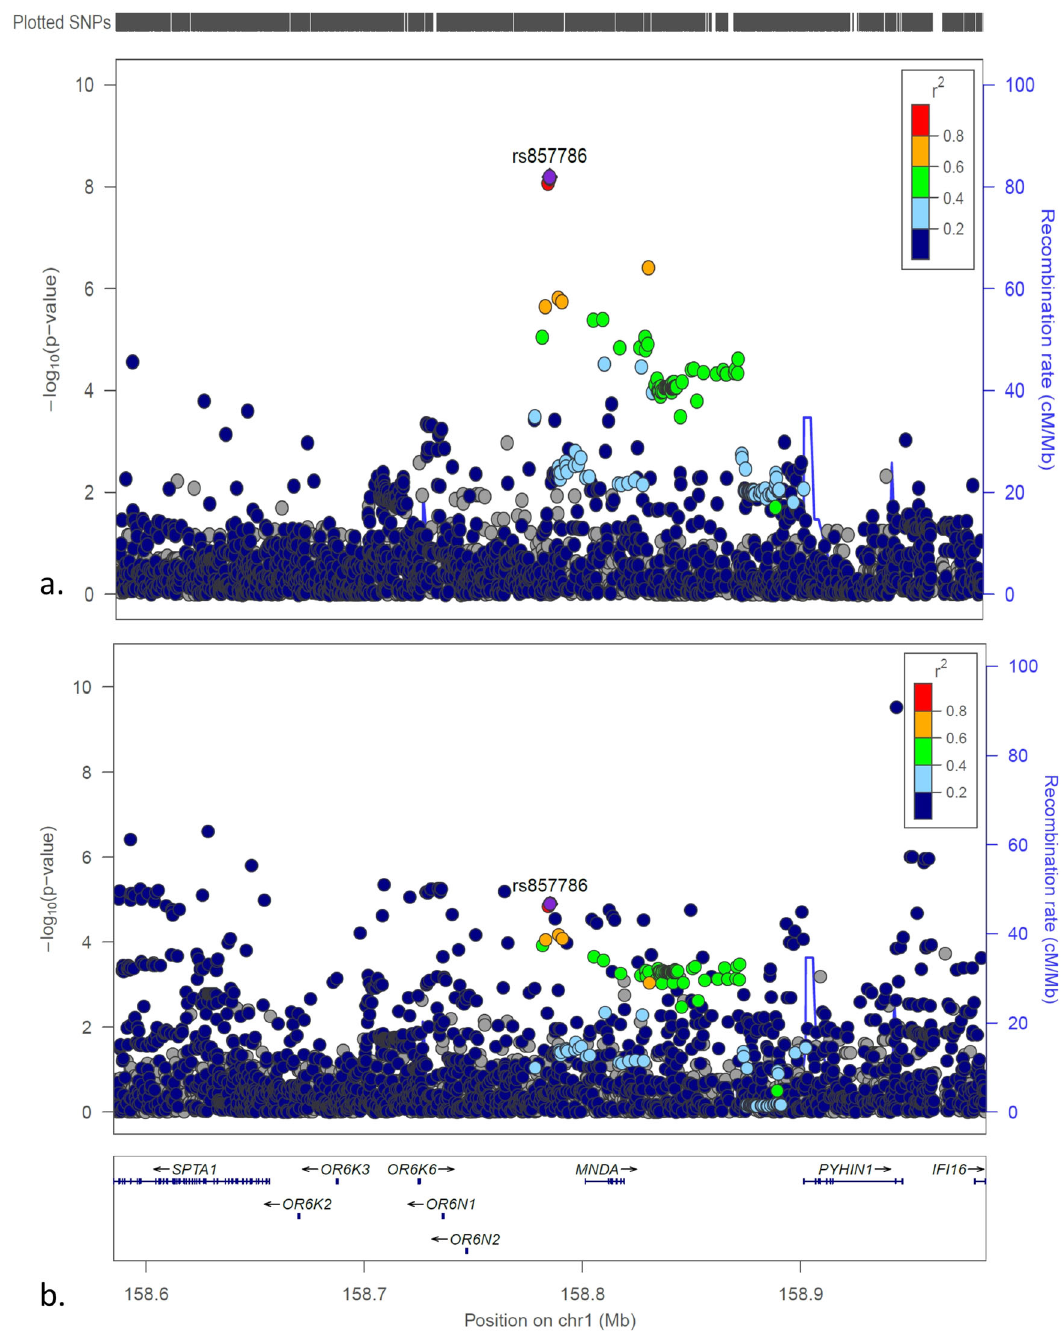
Fig. 2 The LocusZoom plots for the OR6N2/MNDA/PYHIN1 locus. a The plot of the association tests of T1D patients with low T1D GRS compared to controls; ( b ) The plot of the association tests of all T1D patients compared to